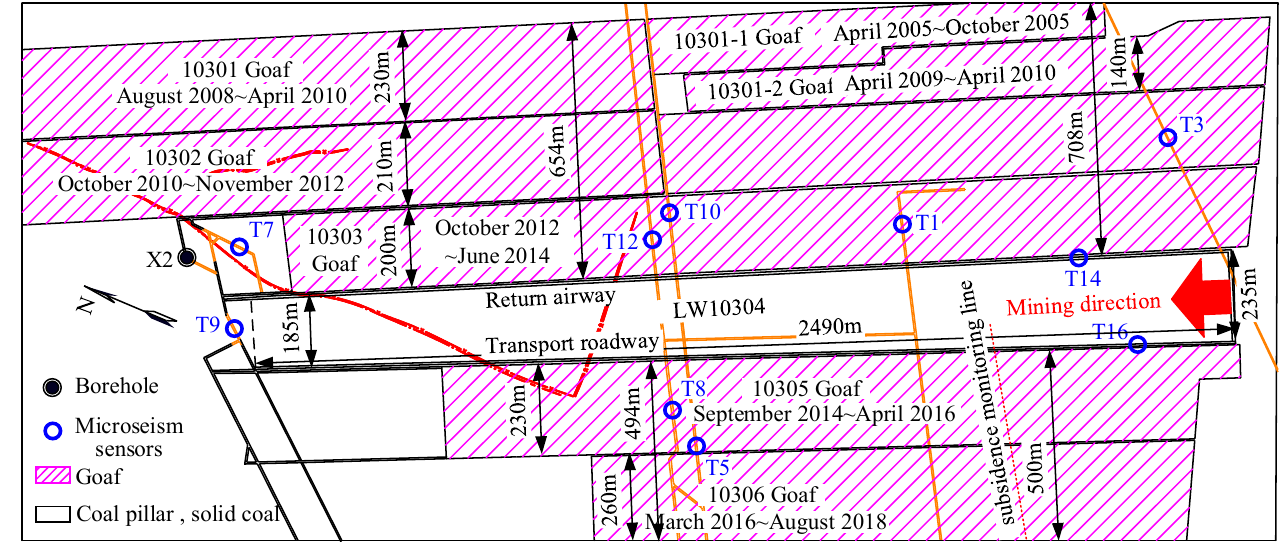
Figure 1. Working face location diagram.